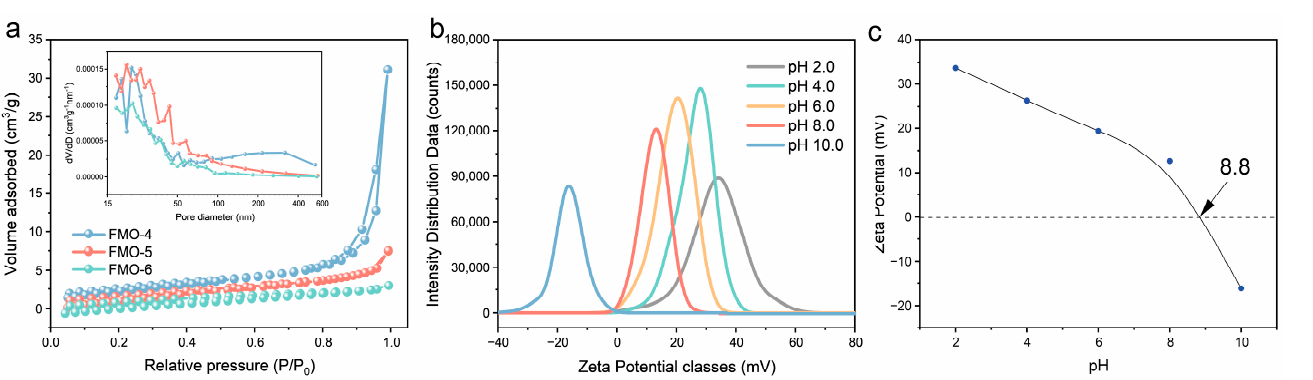
Figure 1. ( a ) Crystal unit cell illustration (blue represents Mo, yellow represents Fe and magenta represents O); ( b ) XRD patterns of the FMO samples; ( c ) FT-IR spectra; ( d ) Raman profiles; ( e ) TEM and HR-TEM images of FMO-6; and ( f ) element maps.